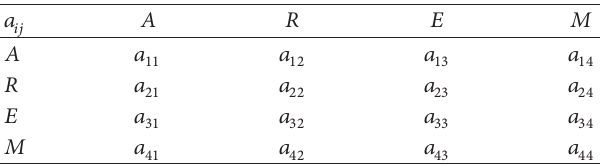
Table 2: Criteria hierarchy judgment matrix. Table 3: Judgment matrix of each